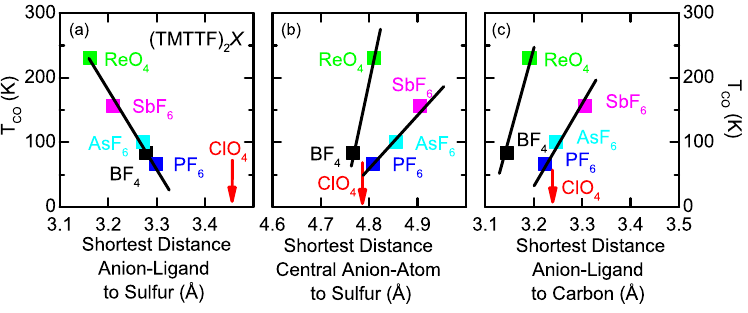
Figure 17. Dependence of the charge order temperature T CO for various Fabre salts (TMTTF) 2 X with different X as indicated. ( a ) Effect on the shortest distance between anion-ligand and TMTTF sulfur atom. ( b ) Change of T CO with the distance between the central atom of the anion and the sulfur atom. ( c ) Influence on the shortest distance from the anion-ligand to the nearest carbon atom. The value for (TMTTF) 2 ClO 4 , which shows no CO, is indicated by a red arrow. All distances were determined at ambient